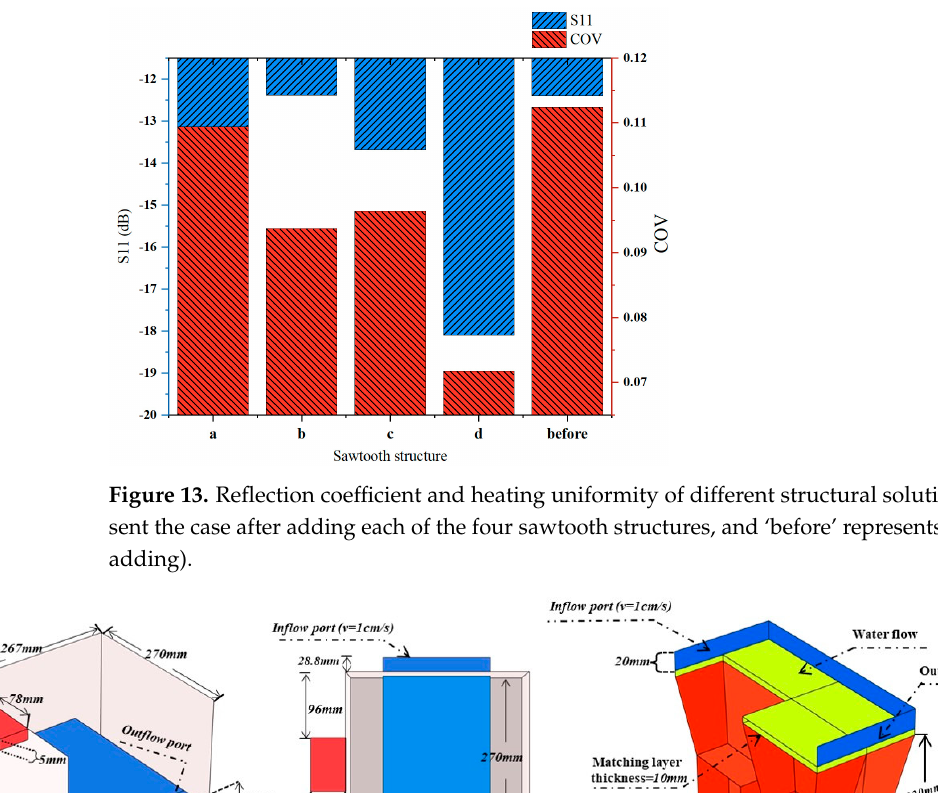
Figure 14. Plane size of the model; ( a ) multimode heating chamber; ( b ) horn antenna heating system.